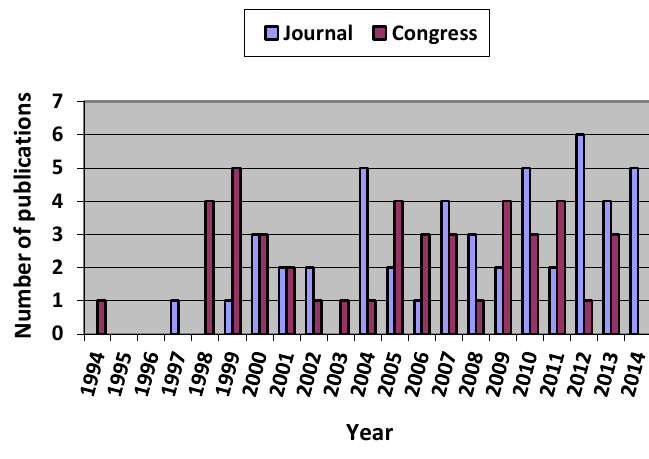
Fig 1. Temporal distribution of the referenced